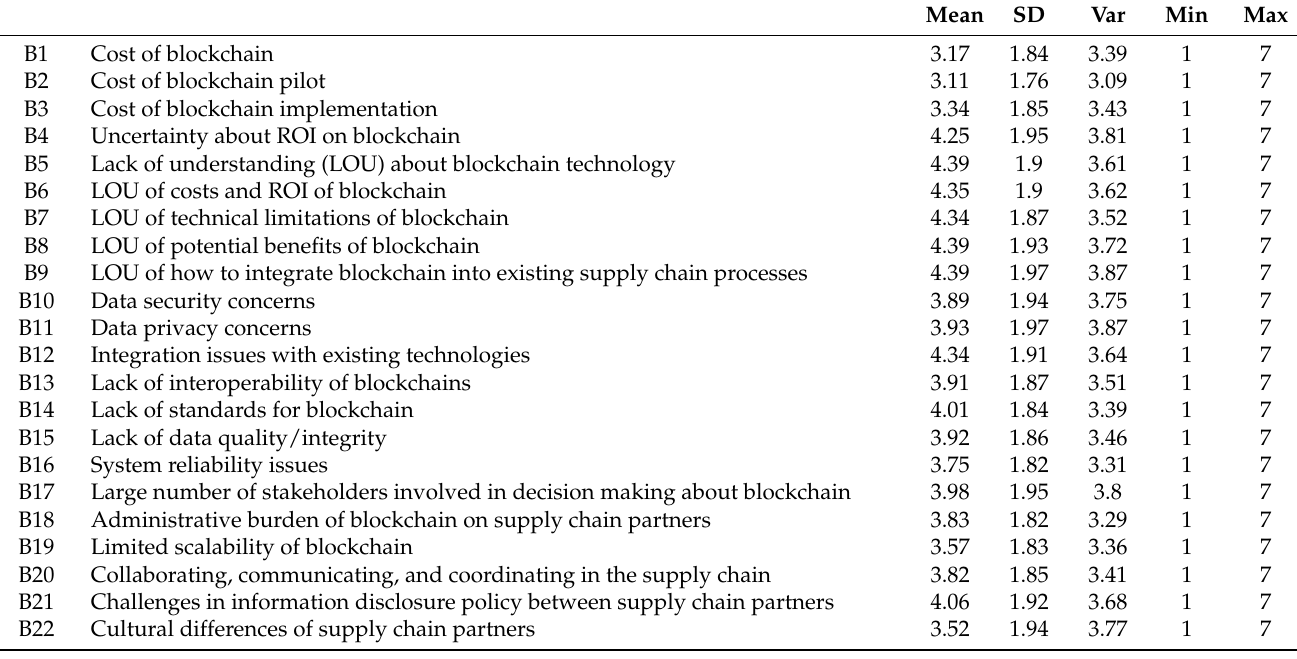
Table A1. Barriers. To what degree is your company experiencing the following barriers to blockchain in the supply chain?